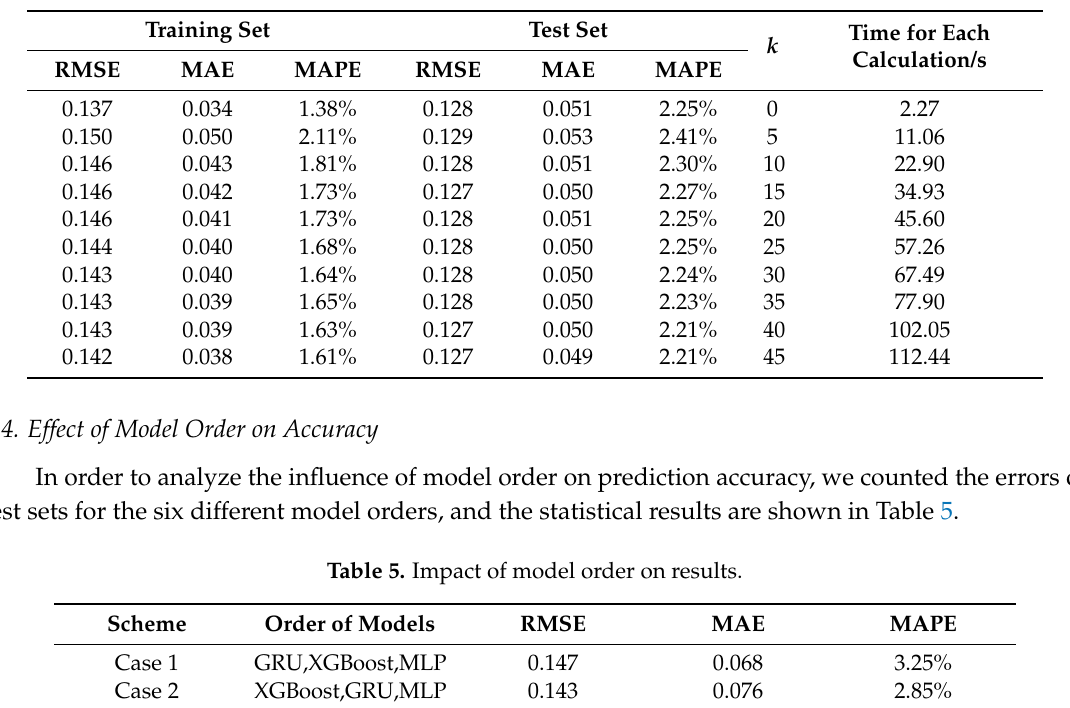
Table 4. The statistical results under different circumstances.